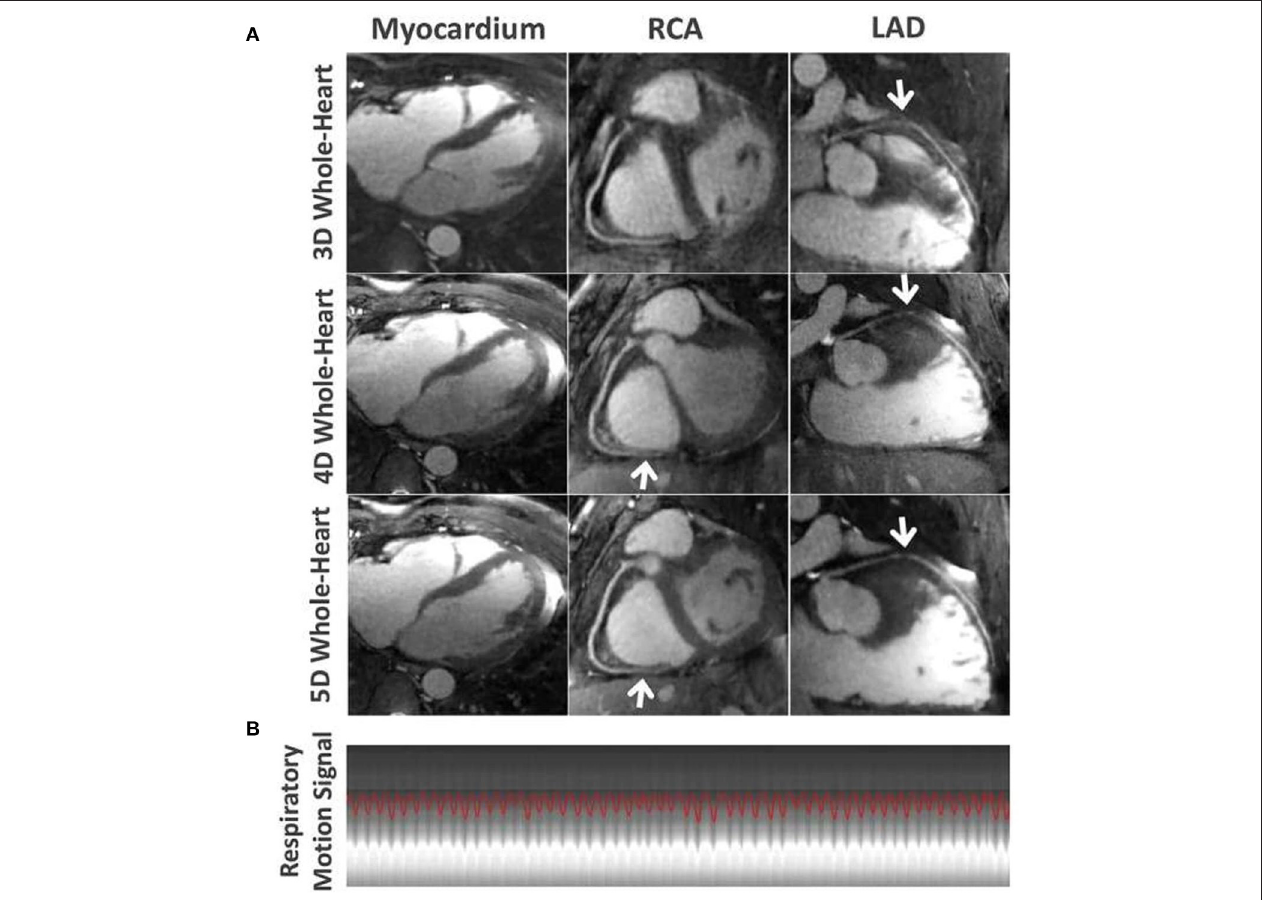
FIGURE 6 | (A) Comparison of the myocardium, the RCA and LAD coronary arteries for different imaging techniques in one subject. 5D whole-heart images (end-expiratory phase) achieved improved visual delineation of the myocardial wall and different segments of the coronary arteries (white arrows) over 4D whole-heart images, and improved delineation of the LAD over self-navigated 3D whole-heart images. (B) Corresponding respiratory motion pattern extracted from the continuous acquired whole-heart dataset in this subject. RCA, right coronary artery; LAD, left anterior descending artery. Adapted with permission from Feng et al. (